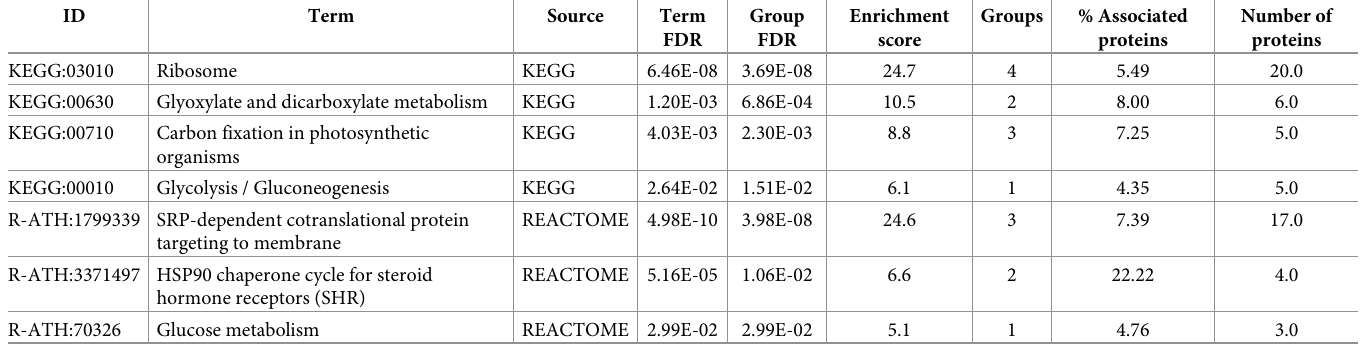
Table 3. Biological pathways uncovered for the selected